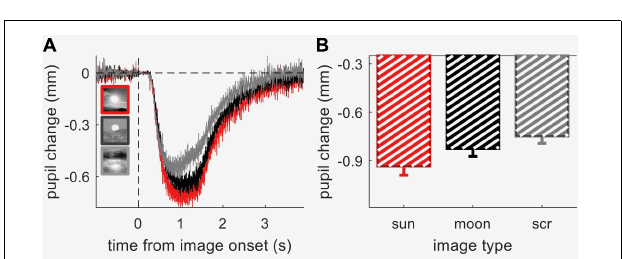
FIGURE 2 | Results from Experiment 1 (neurotypical adults). (A) Timecourses of pupil constrictions (referenced to pre-stimulus baseline) evoked by the three image categories: sun, moon, and phase-scrambled sun images (“scrambled”); thin lines straddling the timecourse give s.e.m. at each timepoint. (B) Peak constriction for the three image categories, averaged across participants. Error-bars show s.e.m. across